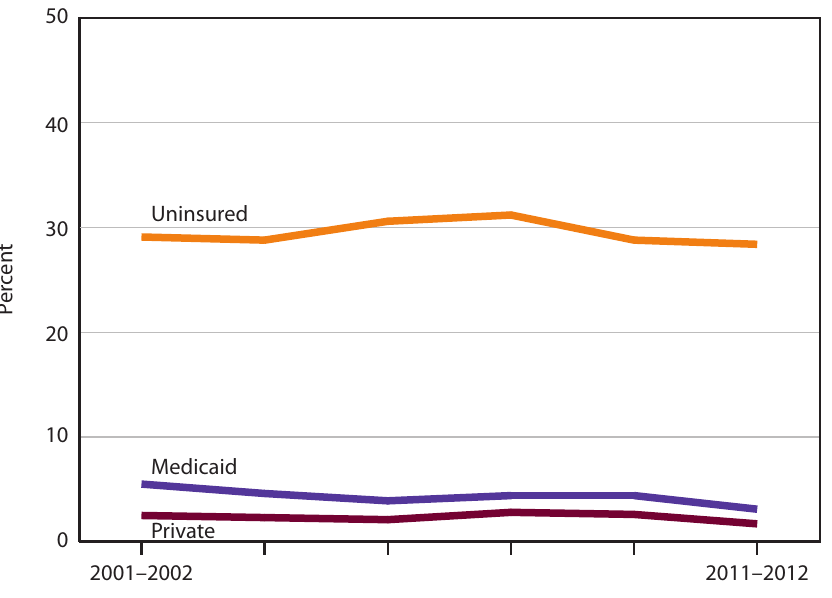
Figure 17. No usual source of care among children under age 18, by type of